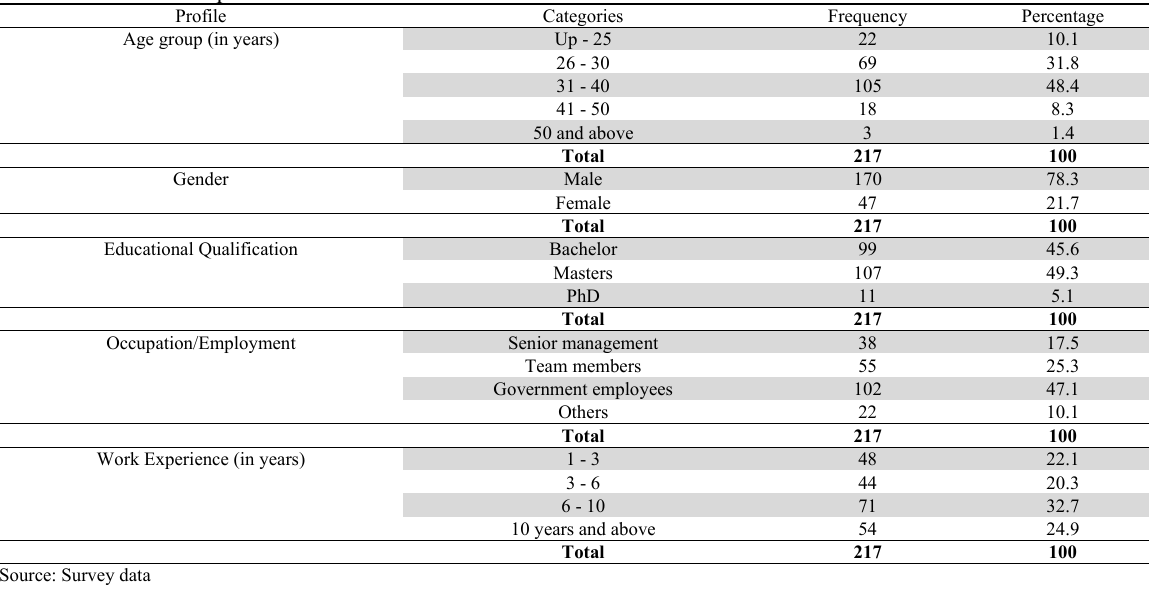
Personal Profile of Respondents